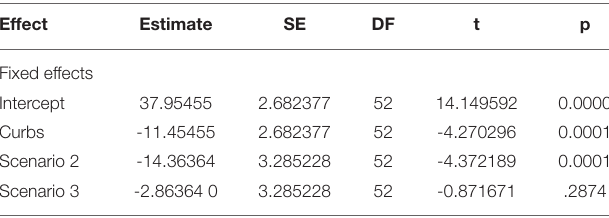
TABLE 2 | Time measures for drawing the walking